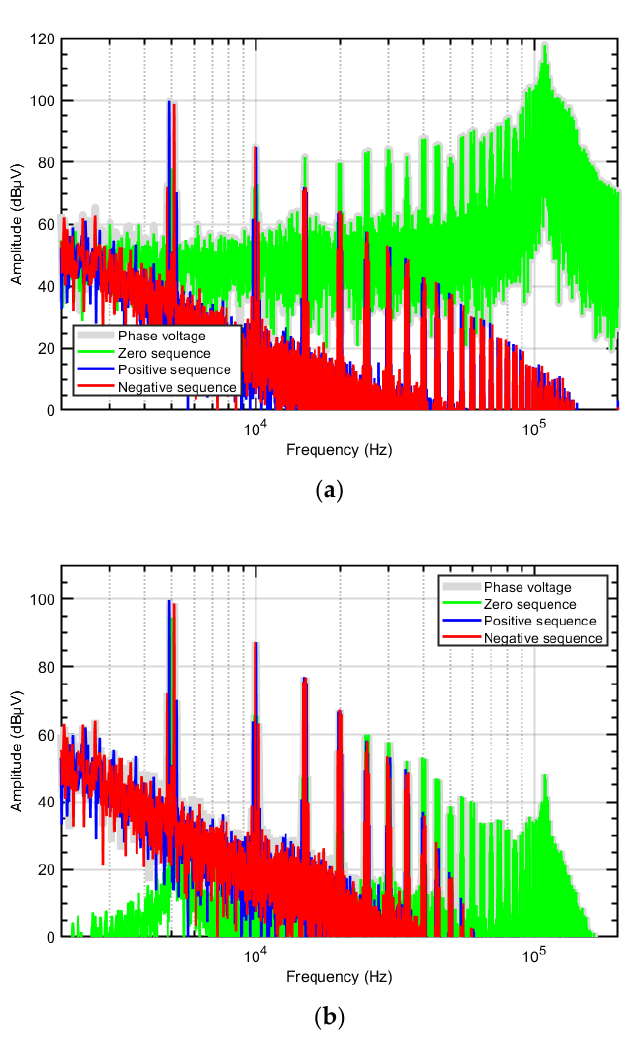
Figure 11. Decomposition of the inverter CEs into positive, negative and zero-sequence components: ( a ) without the EMI filter; ( b ) with the EMI filter.